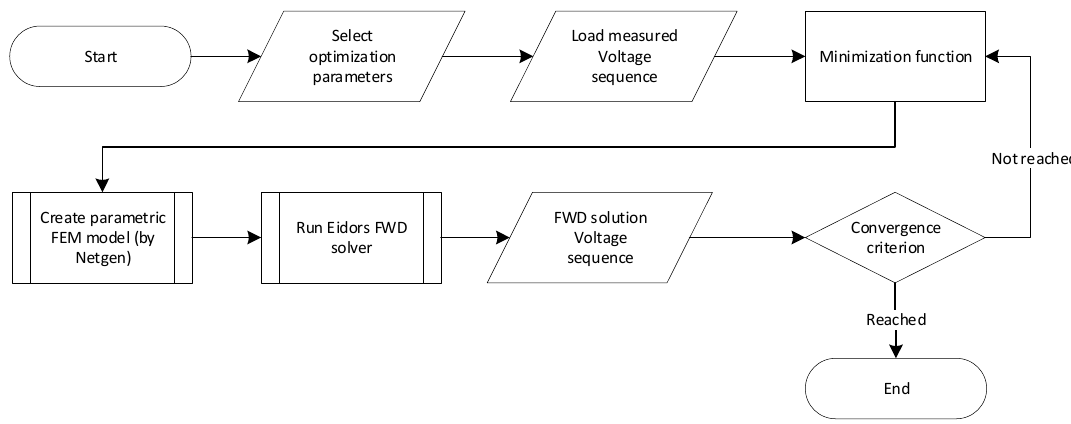
Figure 4. The EIT optimization flowchart based on the measured dataset and selected parameters.